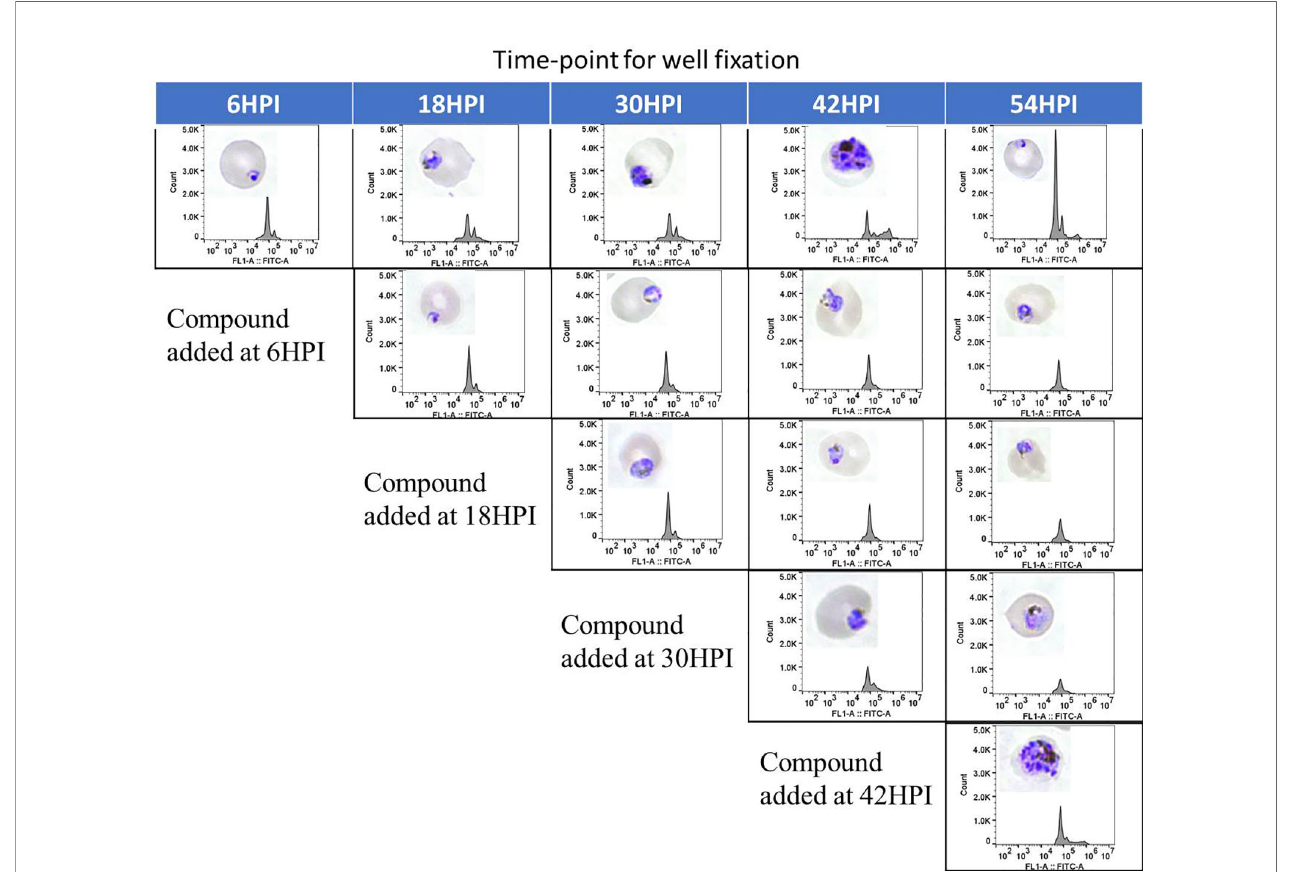
FIGURE 6 | Stage Speci fi c Activity of DC-9237. At different time-points of the malaria parasite intraerythrocytic developmental cycle, DC-9237 was added at a concentration of 3xEC 50 . Additions were at 6, 18, 30, and 42 h post-invasion (hpi). Samples were processed 12 h later and analyzed by Giemsa staining and fl ow cytometry of YOYO-1 stained